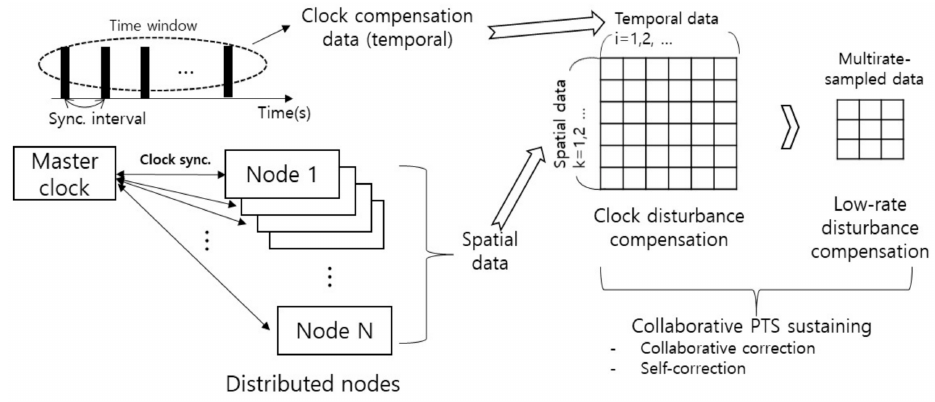
Figure 1. Conceptual diagram of the proposed precision time synchronization (PTS) method.